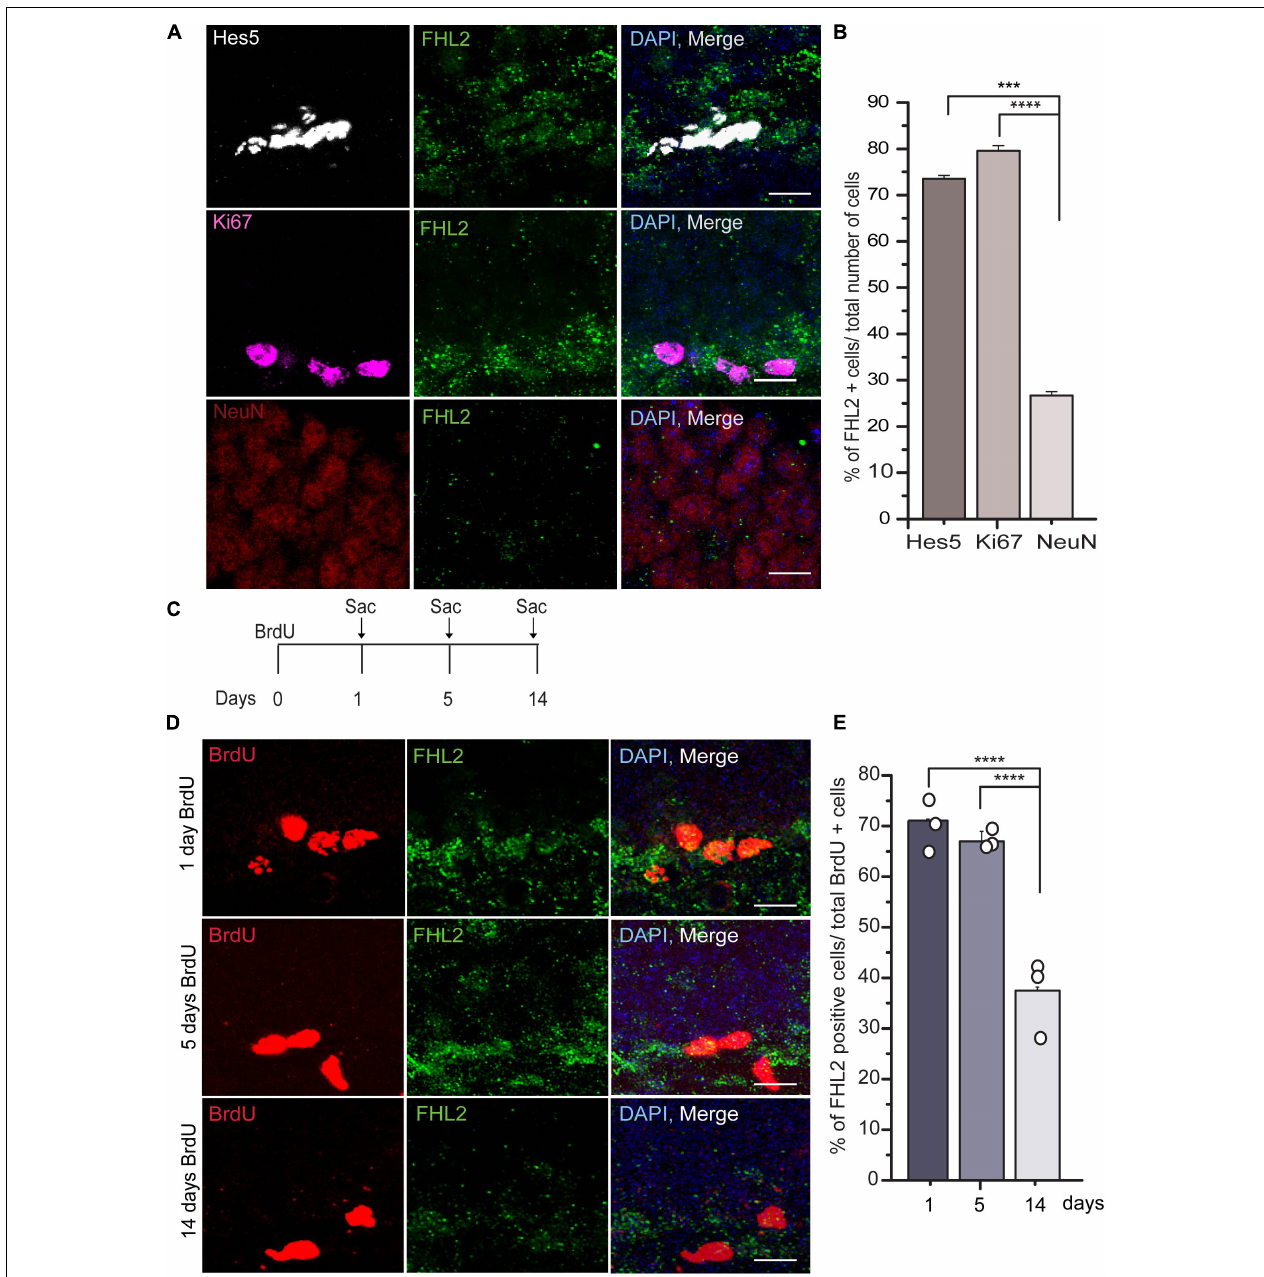
FIGURE 2 | FHL2 expression across developmental time in the dentate gyrus. (A) Representative images of Hes5, Ki67, and NeuN positive with FHL2 colocalization. (B) Quantification of the percentage of FHL2 positive cells in a total number of Hes5, Ki67 and NeuN positive cells. One way ANOVA F (2,87) = 10.399, P < 0.001. Followed by post hoc Tukey HSD test, Hes5 vs. Ki67 ( p > 0.05), Hes5 vs. NeuN ( p = 0.001) and Ki67 and NeuN ( p < 0.001). (C) Timeline for BrdU injection to label the proliferating cells. (D) Representative images of BrdU positive cells colocalized with FHL2 at 1 day, 5 days, and 14 days post-injection. (E) Quantification of colocalization of FHL2 with BrdU positive cells at 1, 5, and 14 days after injection. One way ANOVA F (2,31) = 14.861, P > 0.001. Followed by post hoc Tukey HSD test, BrdU d1 vs. BrdU d5 ( p > 0.05), BrdU d1 vs. BrdU 14 ( p < 0.001) and BrdU d5 vs. BrdU14 ( p < 0.001). Data are presented as mean ± SEM. Scale bar, 10 µ m. N = 3 mice per